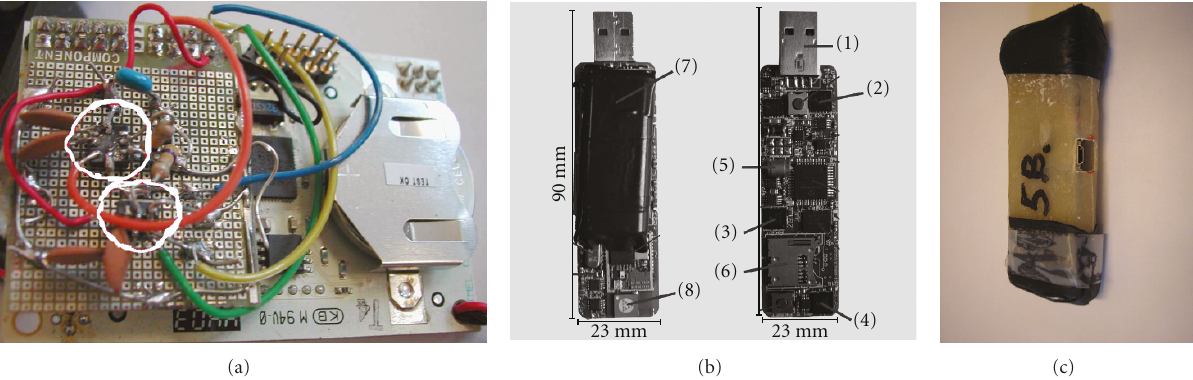
Figure 2: Motion recording sensors (MRS).